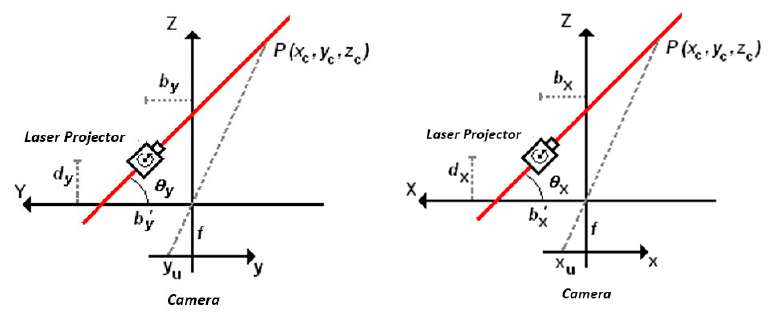
Figure 6. Misalignment parameters.